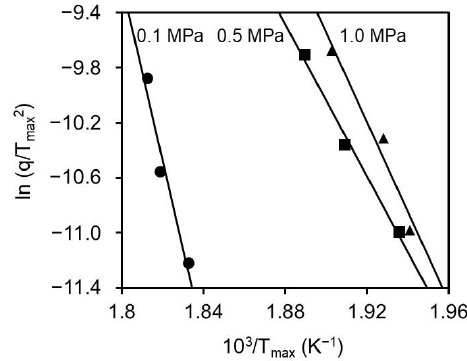
Figure 5. Arrhenius plots of the oxidation–stabilization of mesophase pitch fibers with different applied pressure.